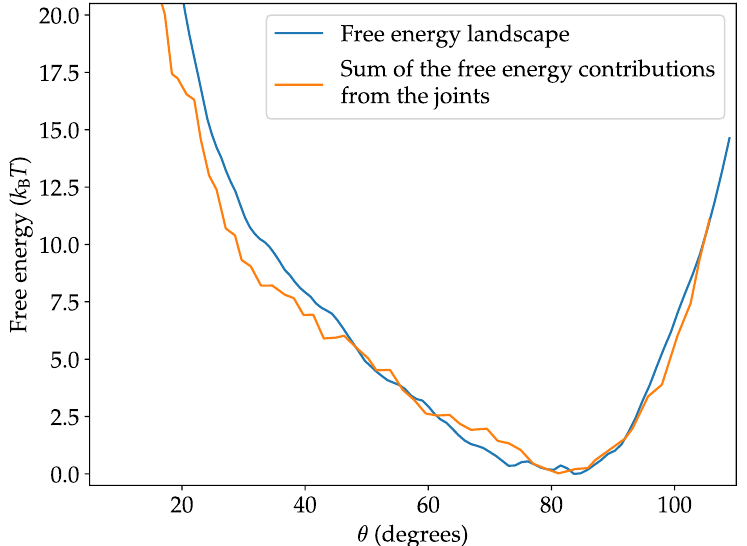
Figure 5. Comparison of the free-energy landscape and the sum of the contributions from the joints.